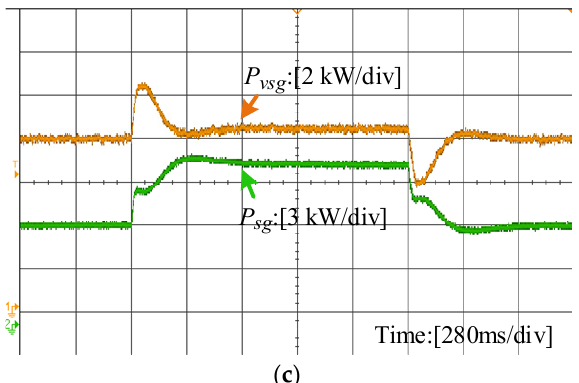
Figure 19. Output active power waveform: ( a ) without the high-pass filter; ( b ) with the high-pass filter; ( c ) with the high-pass filter (parameters optimized).